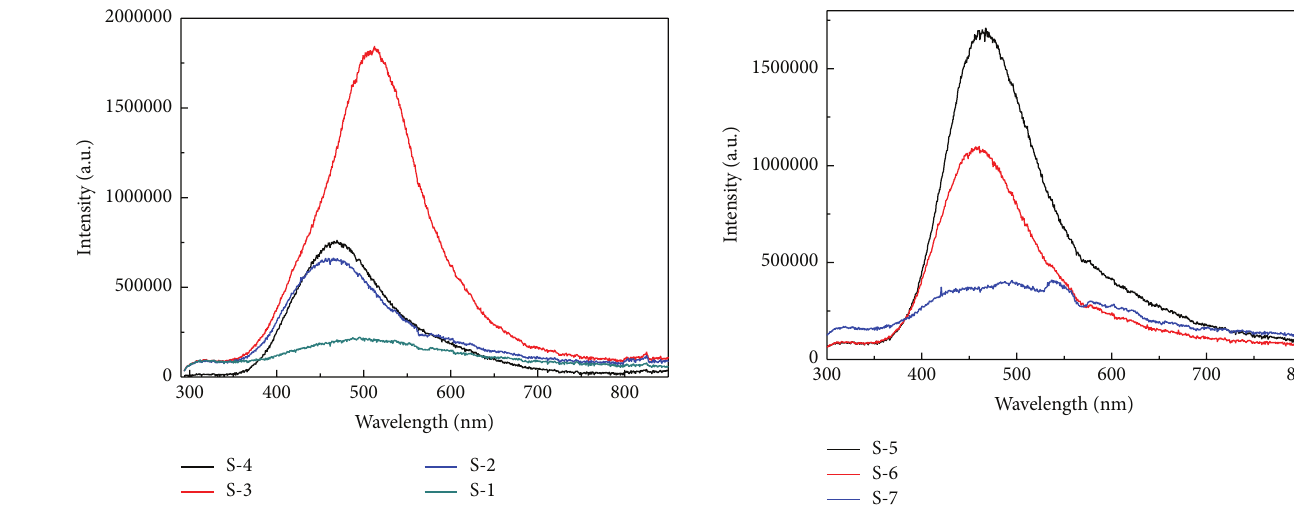
Figure 7: Photoluminescence spectra of the Al-doped CdO thin films surface of S-1, S-2, S-3, and S-4 groups.